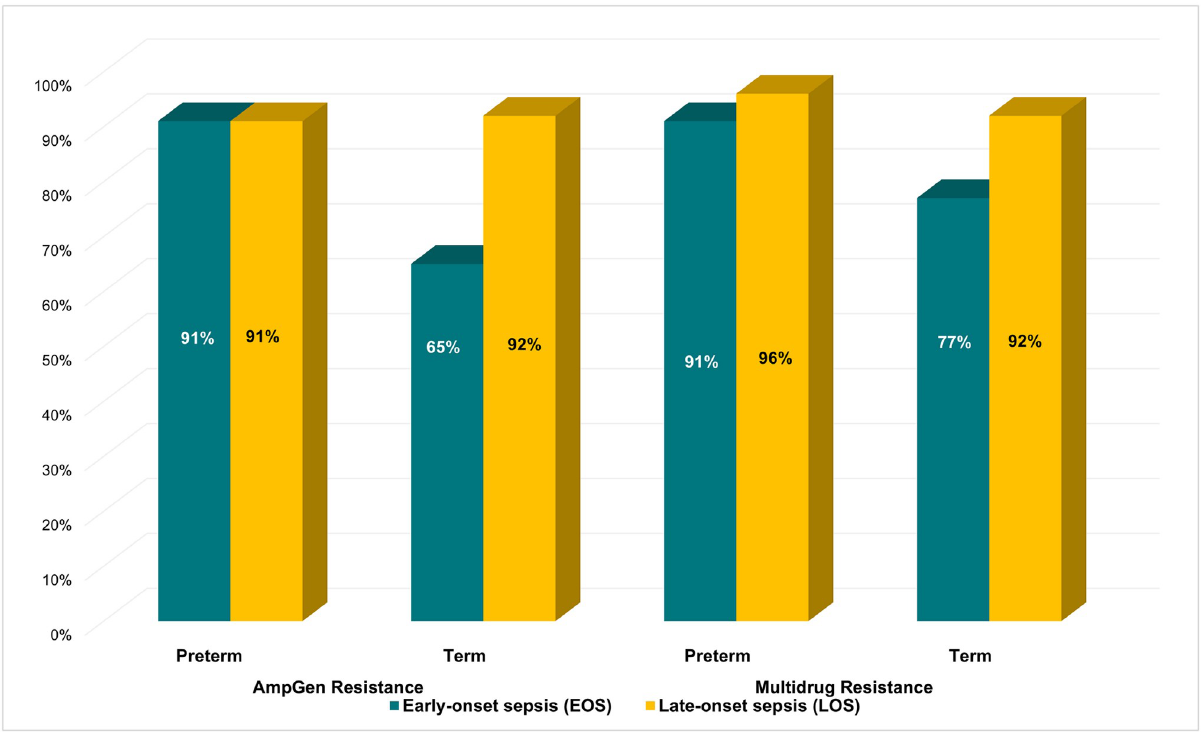
Fig 8. Prevalence of MDR and AmpGen resistance by timing of sepsis (early versus late onset-sepsis) and gestational age (preterm versus term). Among newborns with early-onset sepsis, AmpGen resistance was higher in those born preterm (91%) compared to term newborns (65%). AmpGen resistance and MDR were higher among term newborns who had late-onset sepsis. MDR: multidrug resistance; GNB: gram-negative sepsis.